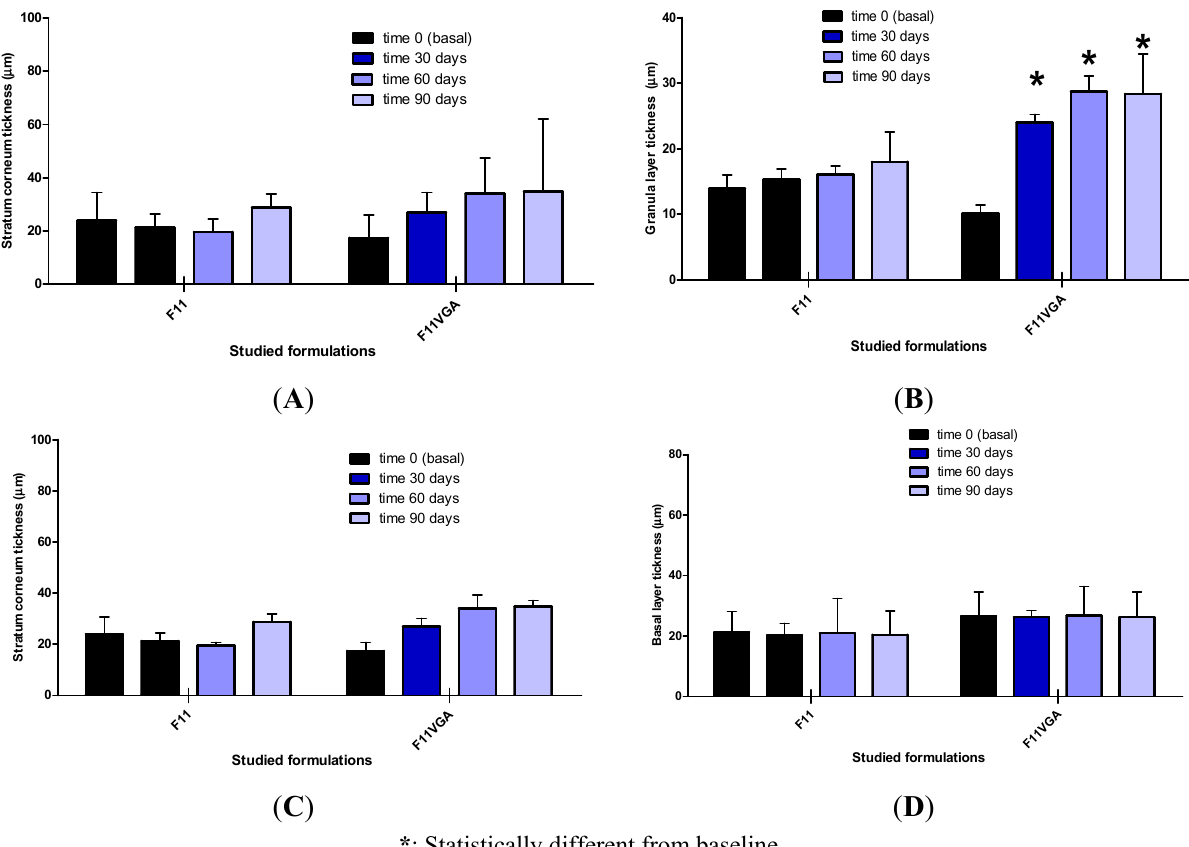
Figure 7. Average and confidence interval 95% (CI95%) thickness of stratum corneum ( A ); spinous layer ( B ); granular layer ( C ) and basal layer ( D ) before (baseline) and after 30, 60 and 90 days of application of the studied formulations in the face of the volunteers (N = 45